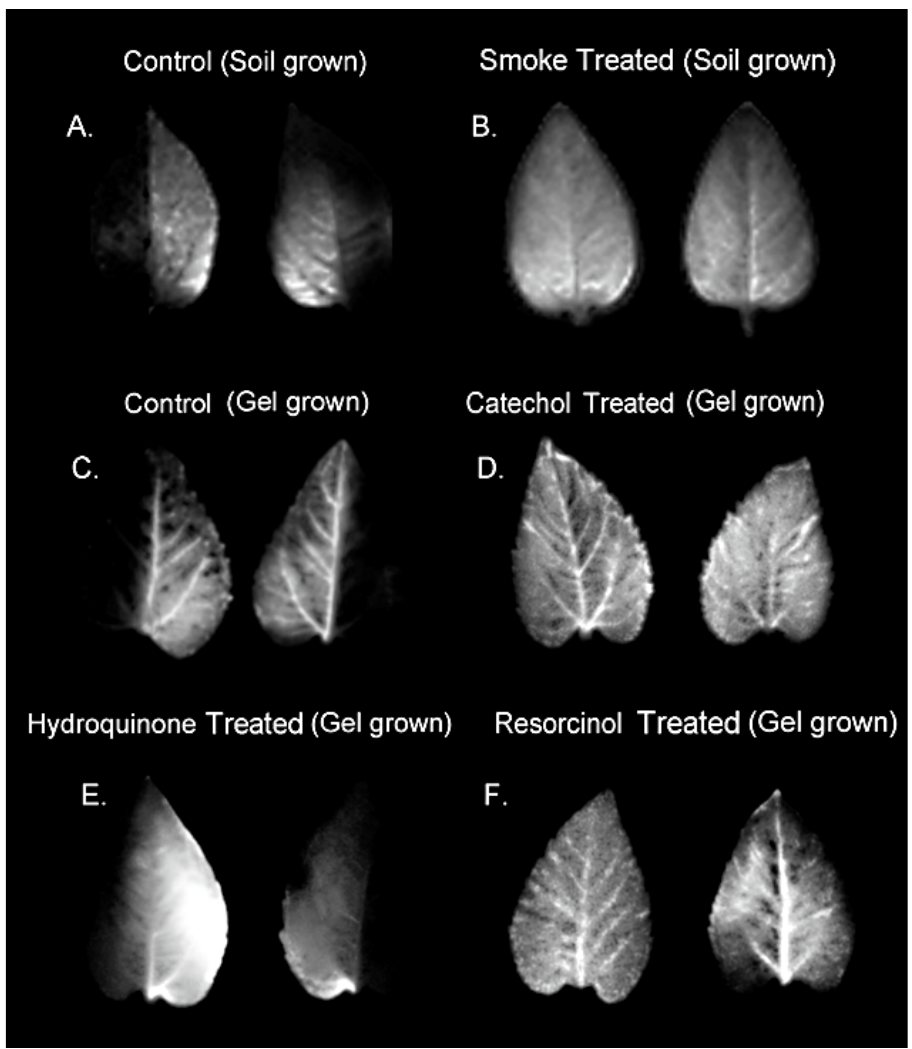
Figure 2. Radiographic images showing patterns of 11 C ‐ photosynthate allocation to sink leaves. Panel ( A ): control sink leaves of plants grown in soil show the characteristic pattern of sectorial vascular connectivity. Panel ( B ): sink leaves from plants grown in liquid smoke treated soil show loss of sectorial connectivity. Panel ( C ): control sink leaves of plants grown in a hydrogel matrix show similar sectorial behavior as soil grown plants. Panel ( D ): sink leaves of plants grown in a hydrogel matrix treated with 150 μ M catechol show loss of sectoriality. Panel ( E ): sink leaves of plants grown in a hydrogel matrix treated with 150 µ M hydroquinone show similar sectorial patterns as control plants. Panel ( F ): sink leaves of plants grown in a hydrogel matrix treated with 150 μ M resorcinol show loss of sectoriality.